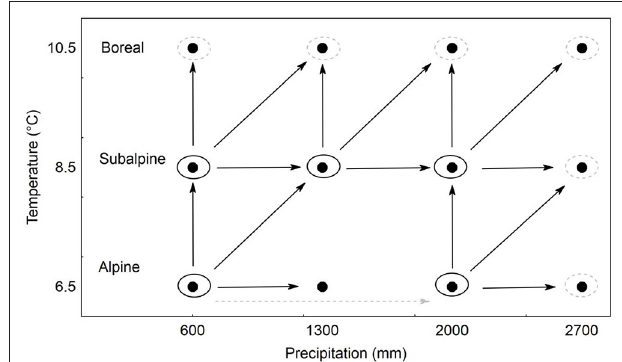
FIGURE 1 | Design of the reciprocal transplant experiment across sites distributed along precipitation and temperature gradients in western Norway. Filled circles indicate the single localities. Arrows indicate the direction of the transplant. Large circles indicate populations planted to their home sites. Only transplants from the source populations encircled in black have been analyzed in this study. Transplants in gray served as controls but have not been used for the main analysis